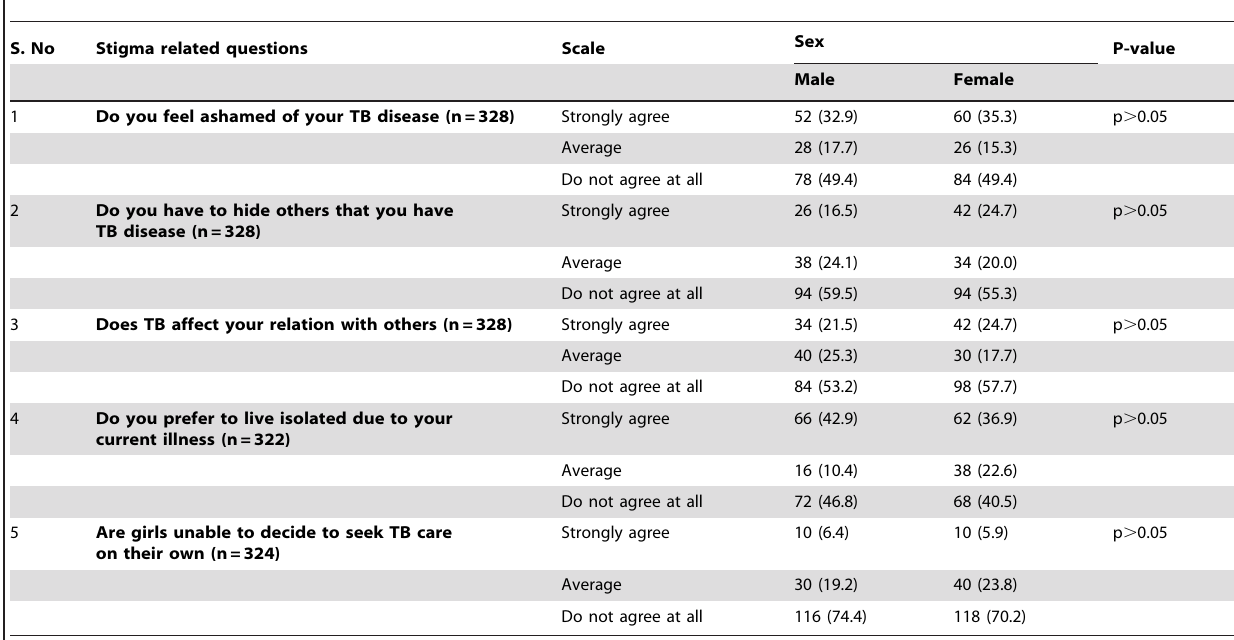
Table 2. Stigma indicating questions stratified by sex of study participants, southern Ethiopia, June-December 2012.